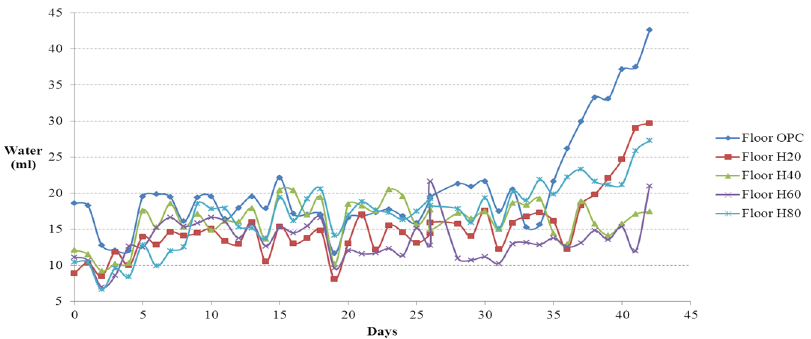
Figure 12. Water intake versus time curves (floor cages).